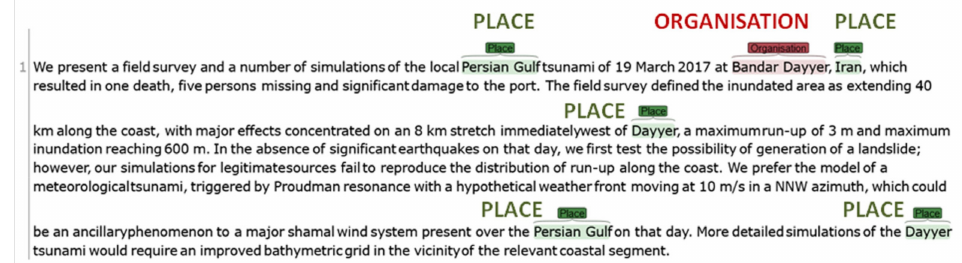
Figure 7. Annotation of the unstructured text about meteotsunami in the FOX framework.